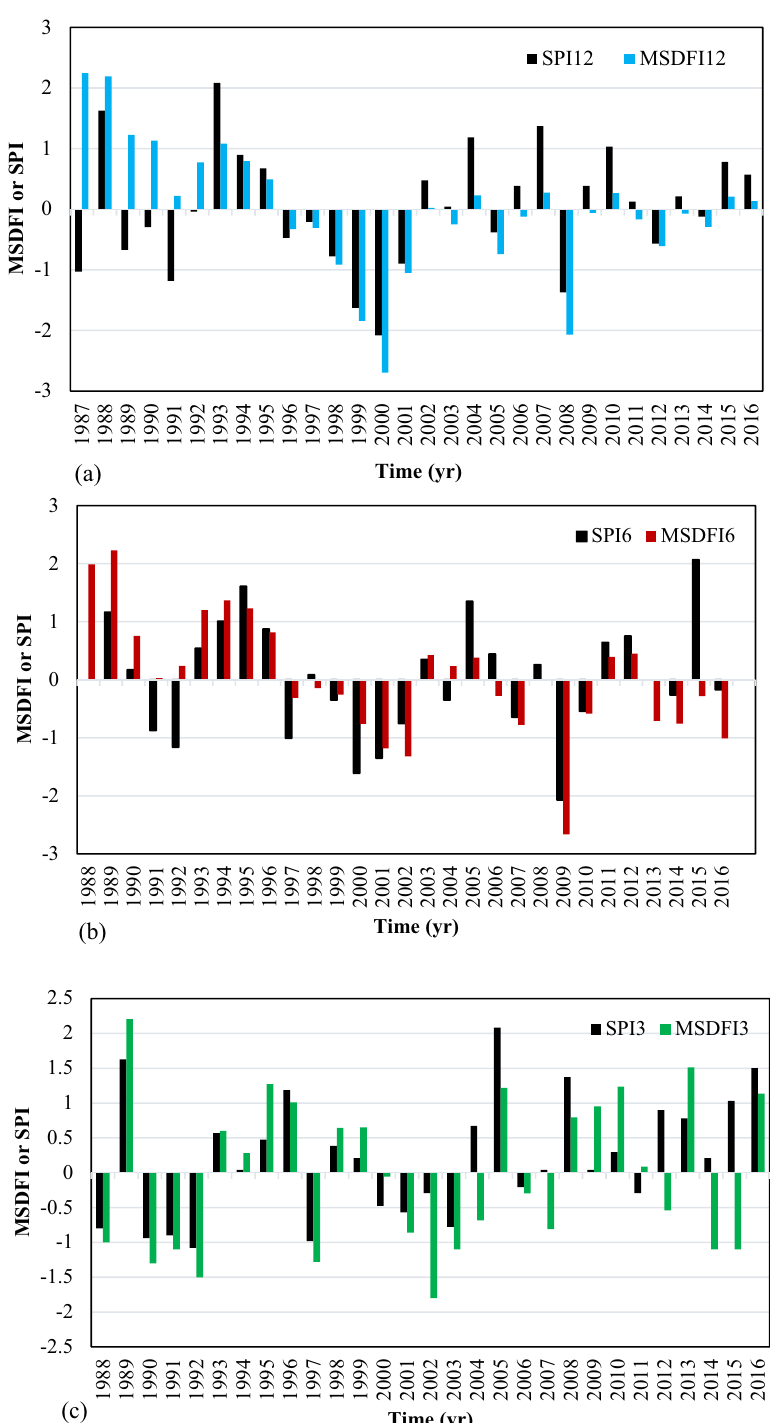
Figure 8. SPI and MSDFI histogram for aggregated ( a ) 12 months ended in September, ( b ) 6 months ended in March, and ( c ) 3 months ended in June for